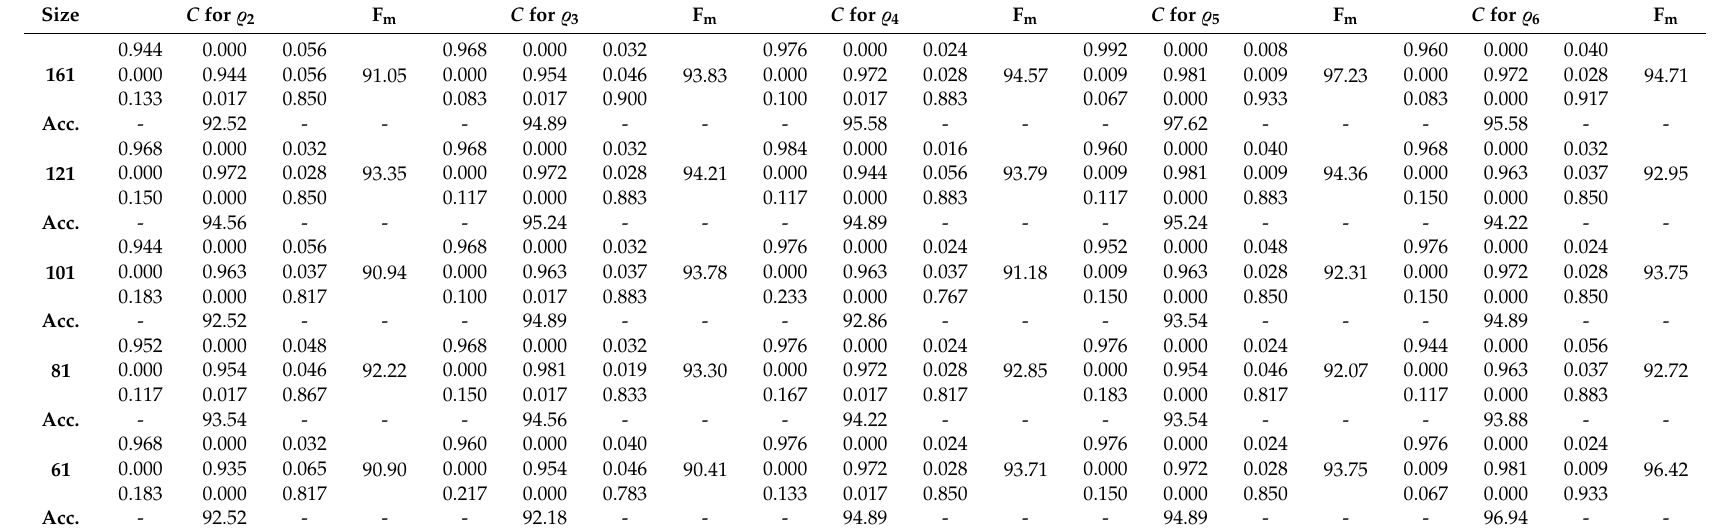
Table 6. Performance of the k-nearest neighbor (K-NN) classifier for di ff erent combinations of textural